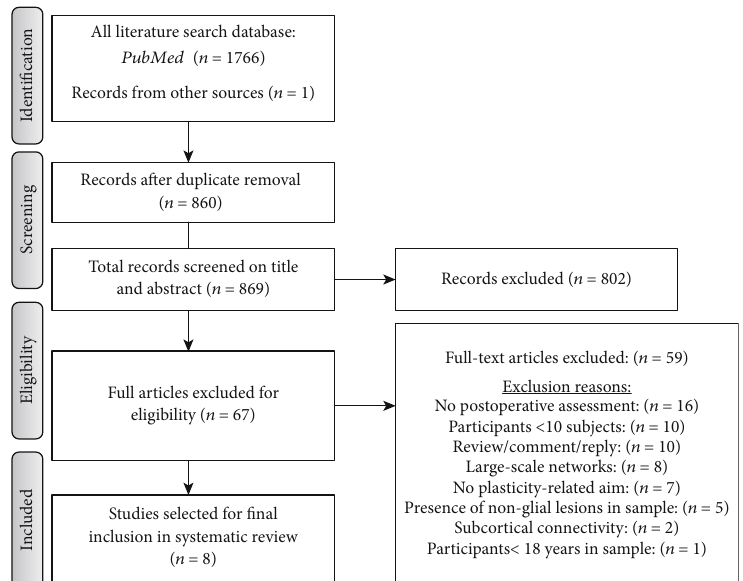
Figure 1: PRISMA fl ow diagram of the conducted systematic search.